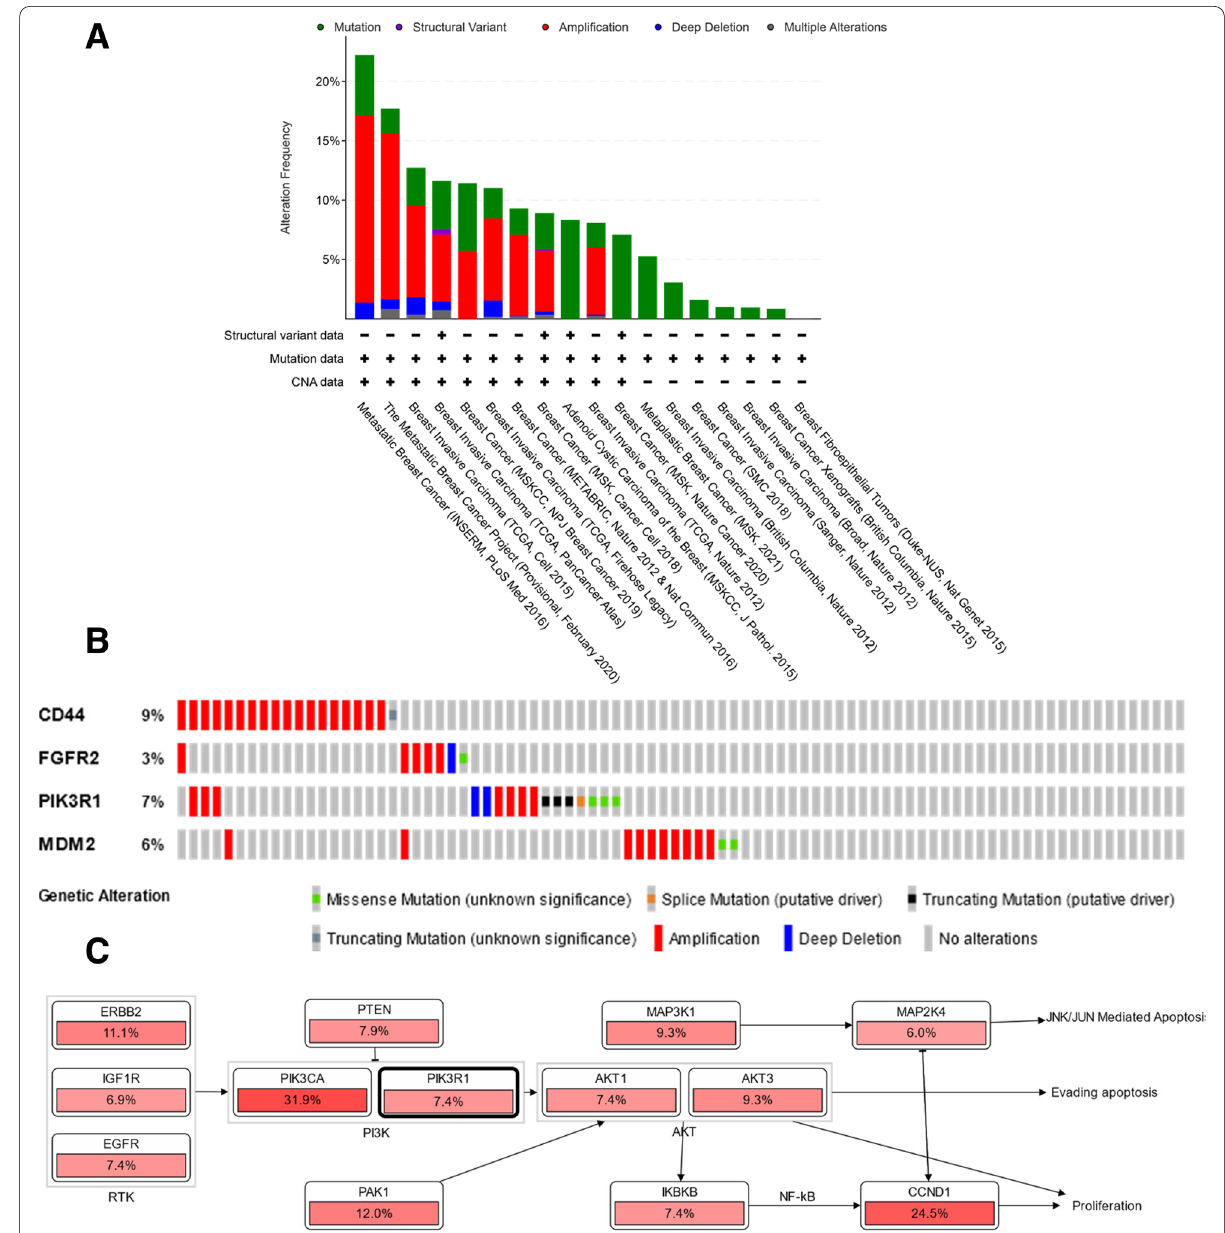
Fig. 4 Analysis of genetic alterations and pathway in the cancer of PTG from breast cancer studies via cBioPortal. A A summary of changes in CD44 , FGFR2 , PIK3R1 , and MDM2 across 18 studies on breast cancer. B Summary of genetic alterations in CD44 , FGFR2 , PIK3R1 , and MDM2 in breast cancer samples based on the study of Lefebvre et al. (2016). C Pathways related to genetic alterations in PIK3R1 on the PI3K/AKT signaling